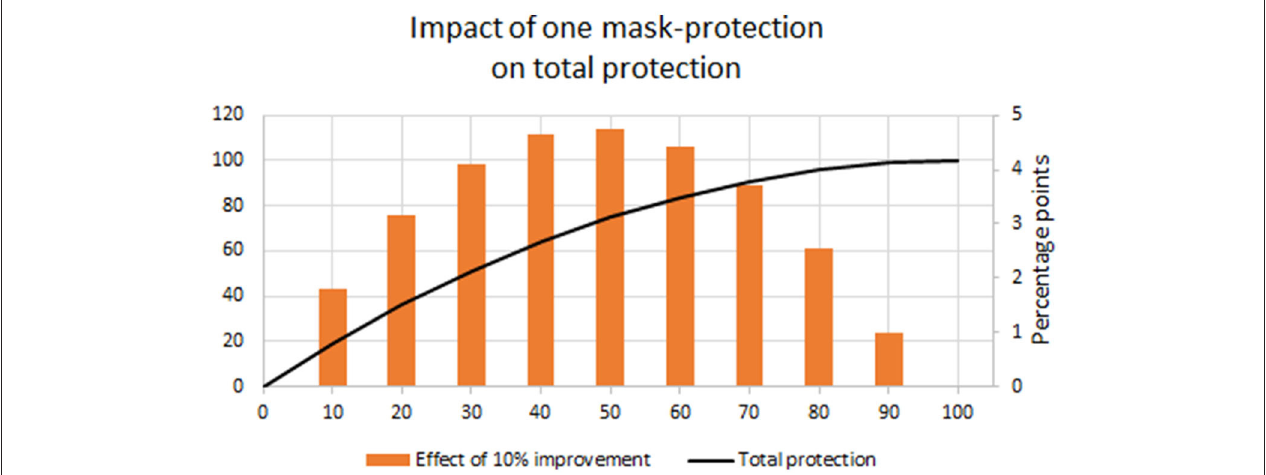
FIGURE 1 | Total protection in % (by masking an infected and a healthy individual who are in contact) (orange line, scale to the left) and marginal utility of increased one mask-protection as a function of one mask-protection. The gray bars with the scale to the right show the effect on total protection (in percentage points) of a 10% increase in one